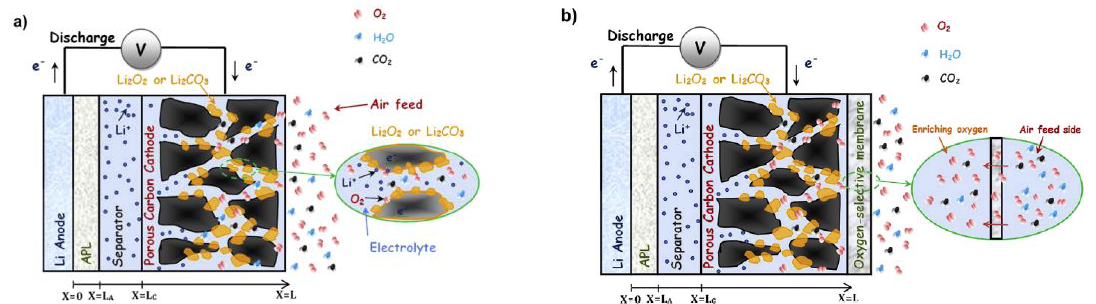
Figure 28. Schematic of the computation domain of a Li-air battery during discharge operation. ( a ) Li-air battery operation with ambient air feeding. Inset demonstrates the formation of discharge products, such as Li 2 O 2 and Li 2 CO 3 , covering the porous carbon surface; ( b ) Li-air battery protected by an oxygen-selective membrane at the cathode. Reprinted from Sahapatsombut et al. [38], with permission from Elsevier.